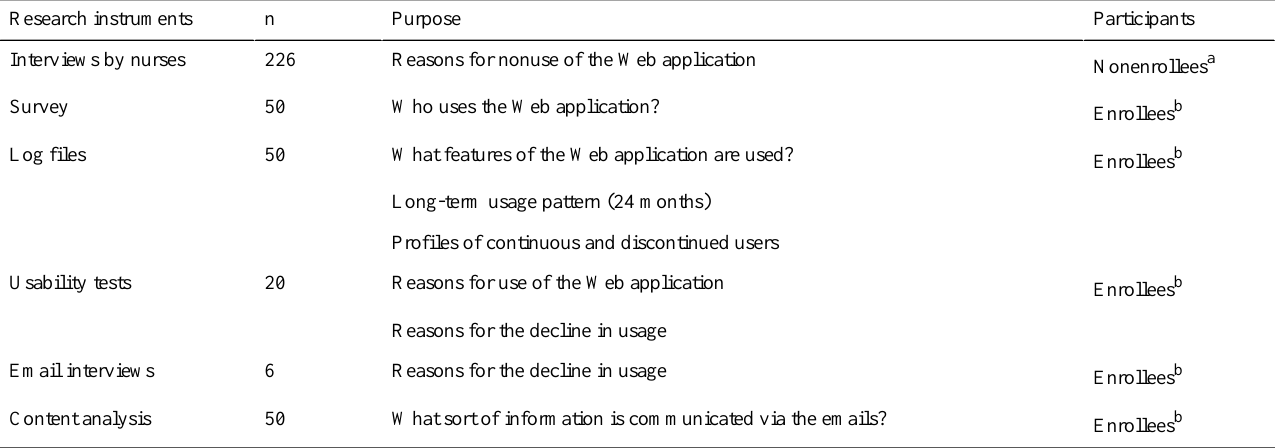
Table 1. Research instruments and study characteristics ParticipantsPurposenResearch